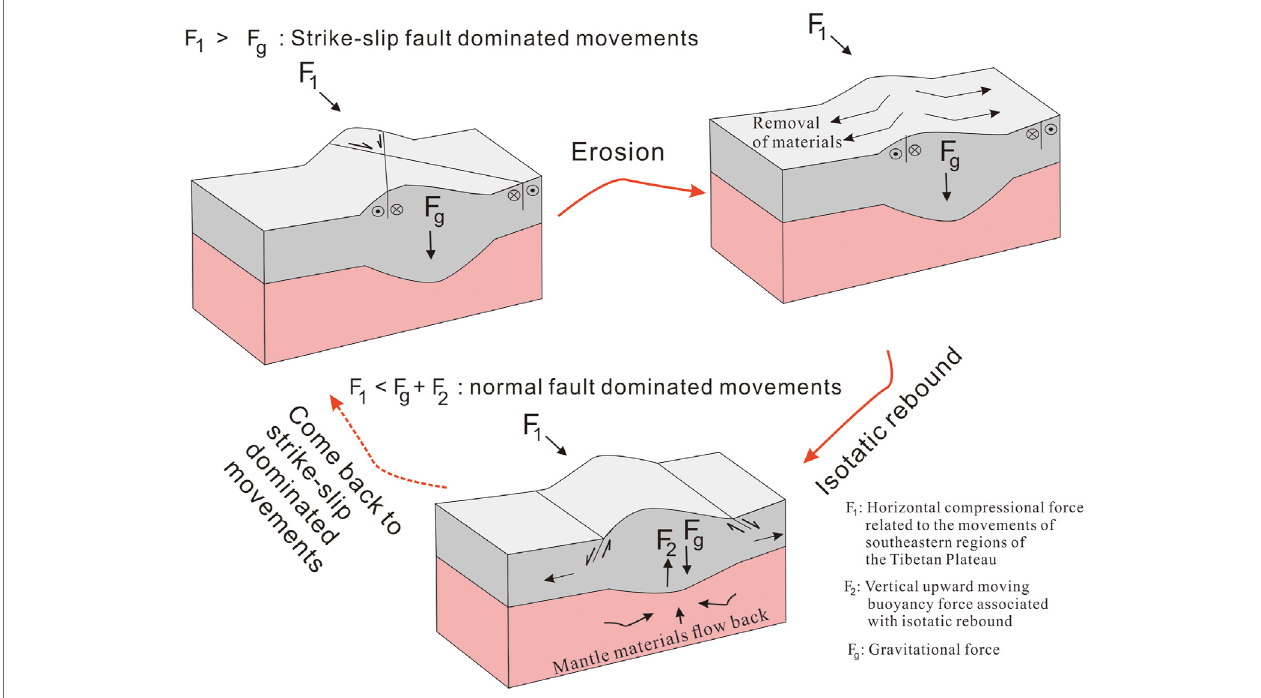
FIGURE 13 | Cartoon of the interpreted model for repeated cycles of normal and strike-slip faulting as a result of interaction between tectonics and erosion in the Fansipan and Tule mountain ranges.